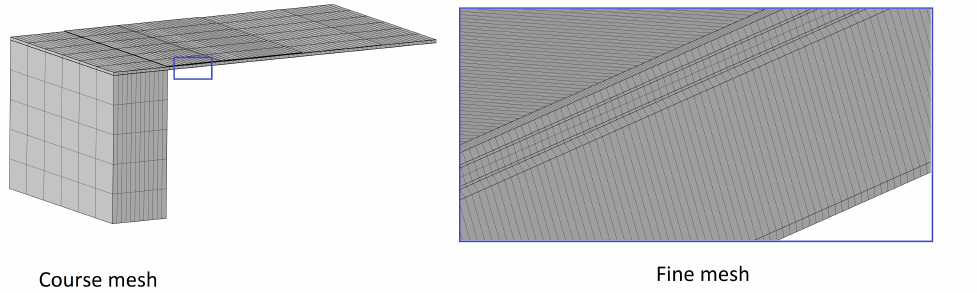
Figure 2. Longitudinally controlled partitioning for meshing the cantilever beam to achieve convergence with the minimum number of